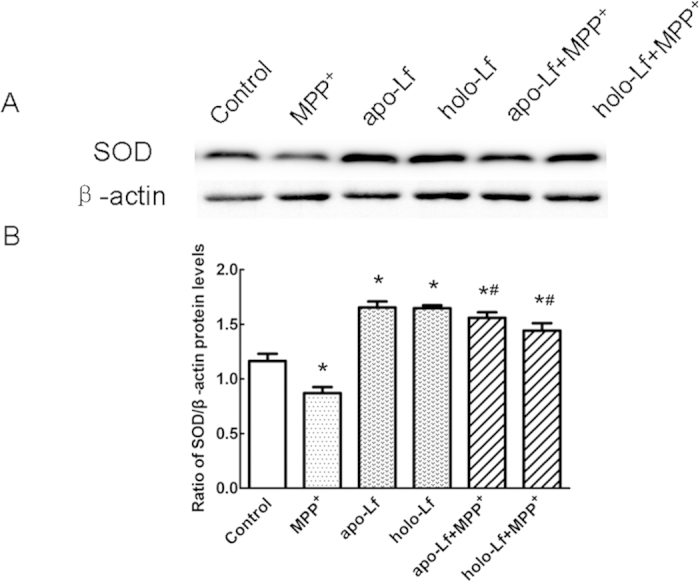
Cu/Zn–SOD protein levels in MPP+-treated VM neurons with apo-Lf or holo-Lf pretreatment.(A) Western blots were applied to detect Cu/Zn–SOD protein levels. Cu/Zn–SOD protein level was down-regulated in VM neurons by MPP+. Apo-Lf or holo-Lf increased the expression of Cu/Zn–SOD in VM neurons compared with the control group. Apo-Lf or holo-Lf pretreatment reversed the decrease of Cu/Zn–SOD expression in MPP+-treated cells. β-actin was used as a loading control. (B) Statistical analysis. Data were presented as the ratio of Cu/Zn–SOD to β-actin. Each bar represented the mean ± S.E.M. *P < 0.05, compared with the control; #P < 0.05, compared with MPP+ group; n = 6.